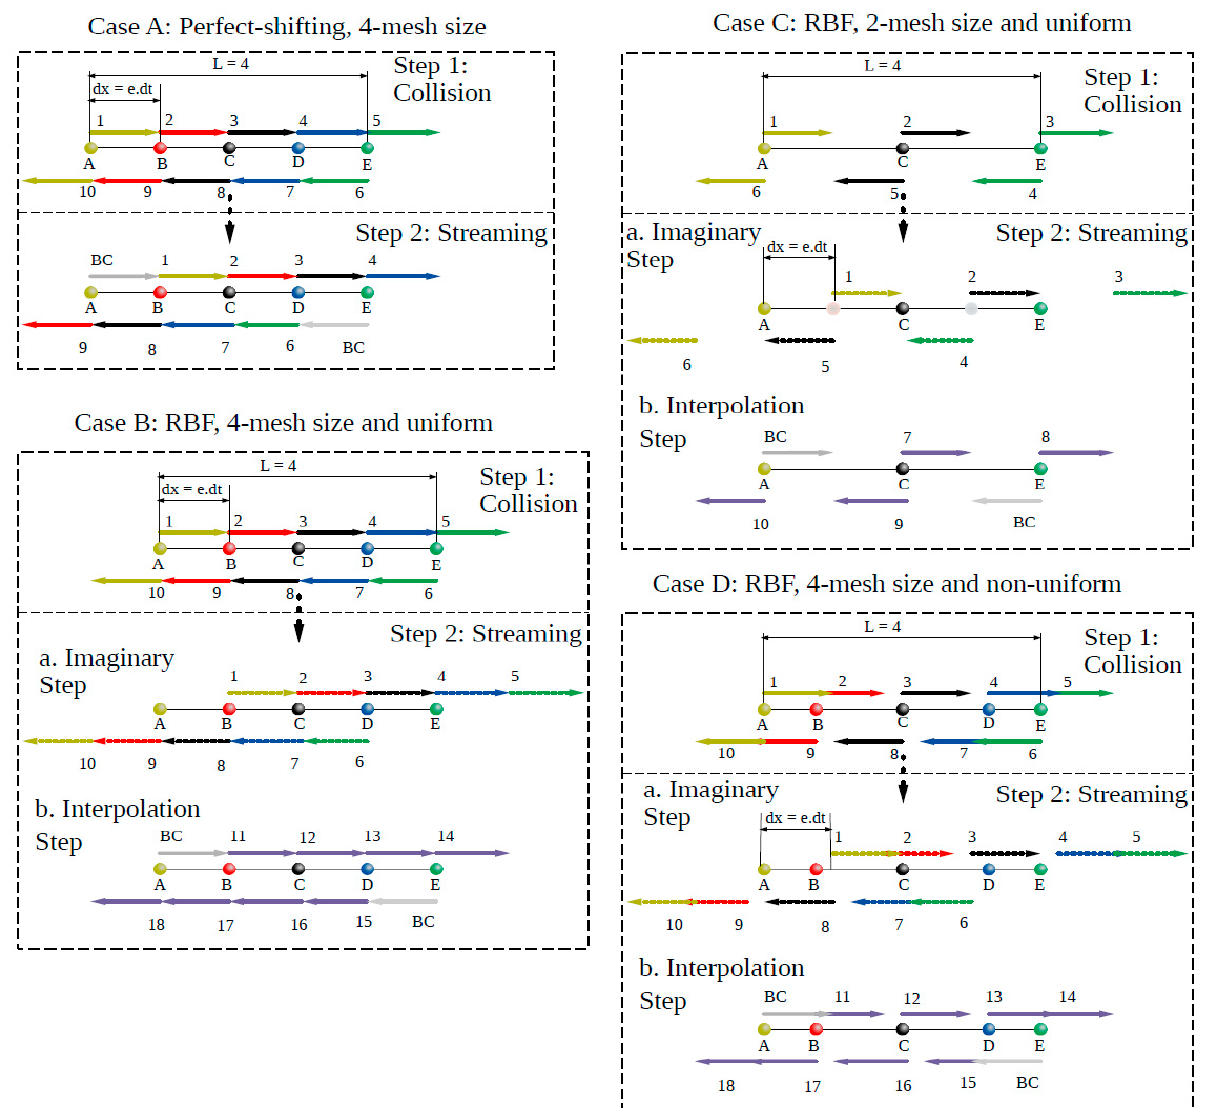
Figure 1. Streaming step of LBM by perfect shifting and the RBF method. In all presented cases, the arrows with the BC label represent the distribution functions that are calculated based on the boundary conditions.